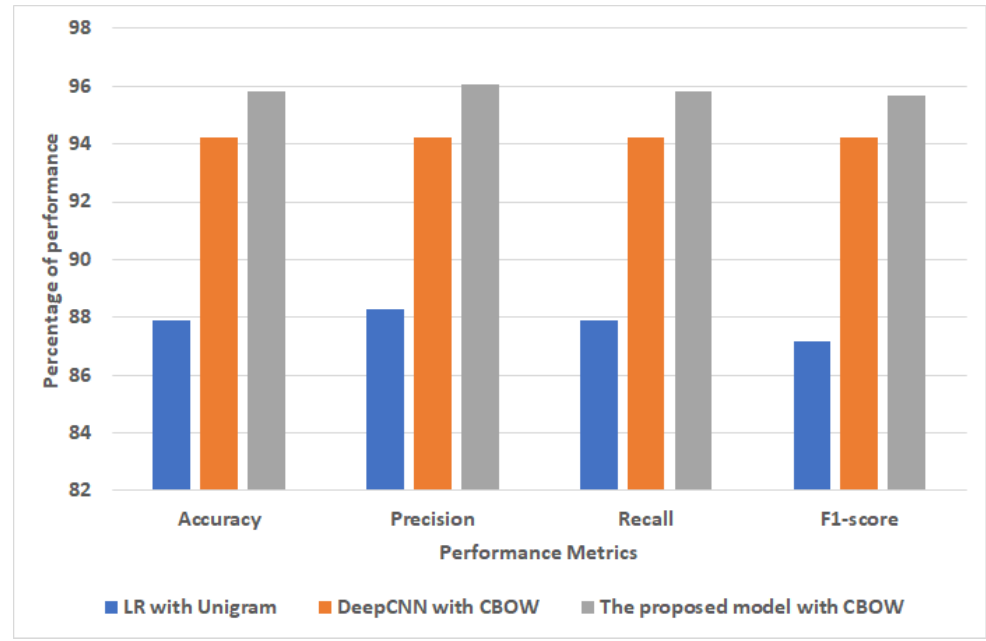
Figure 9. The best models for the Sub-AHS dataset.